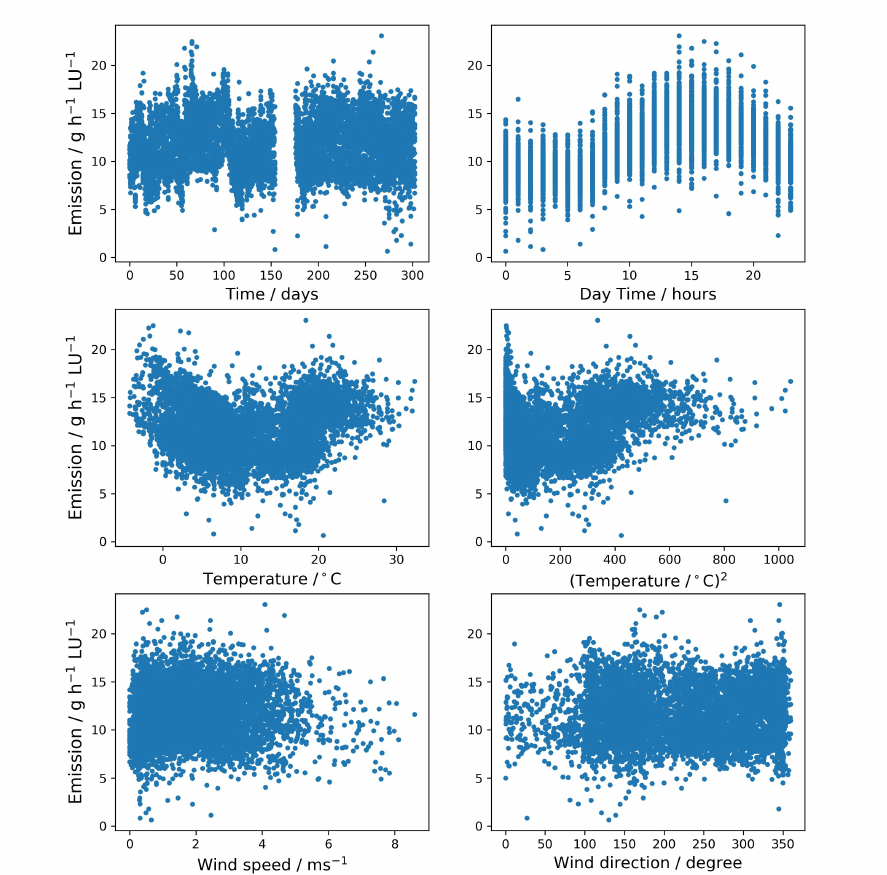
Figure 2. Scatter plots between the target size (emission) and the input features (year-time, day-time, temperature, squared temperature, wind speed and wind